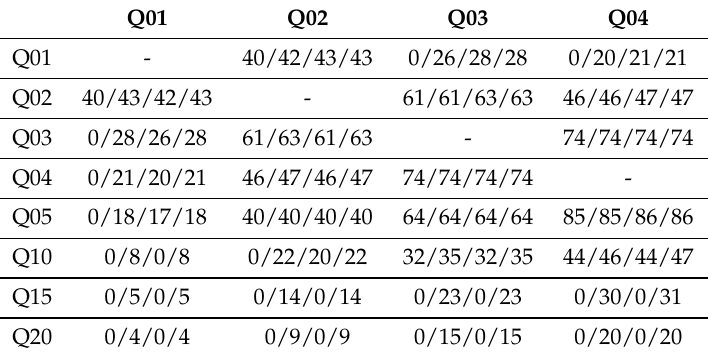
Table 5. Test results for similar plain text files with SiSe, part 1 (hash vs. hash/file vs. hash/hash vs. file/file vs.